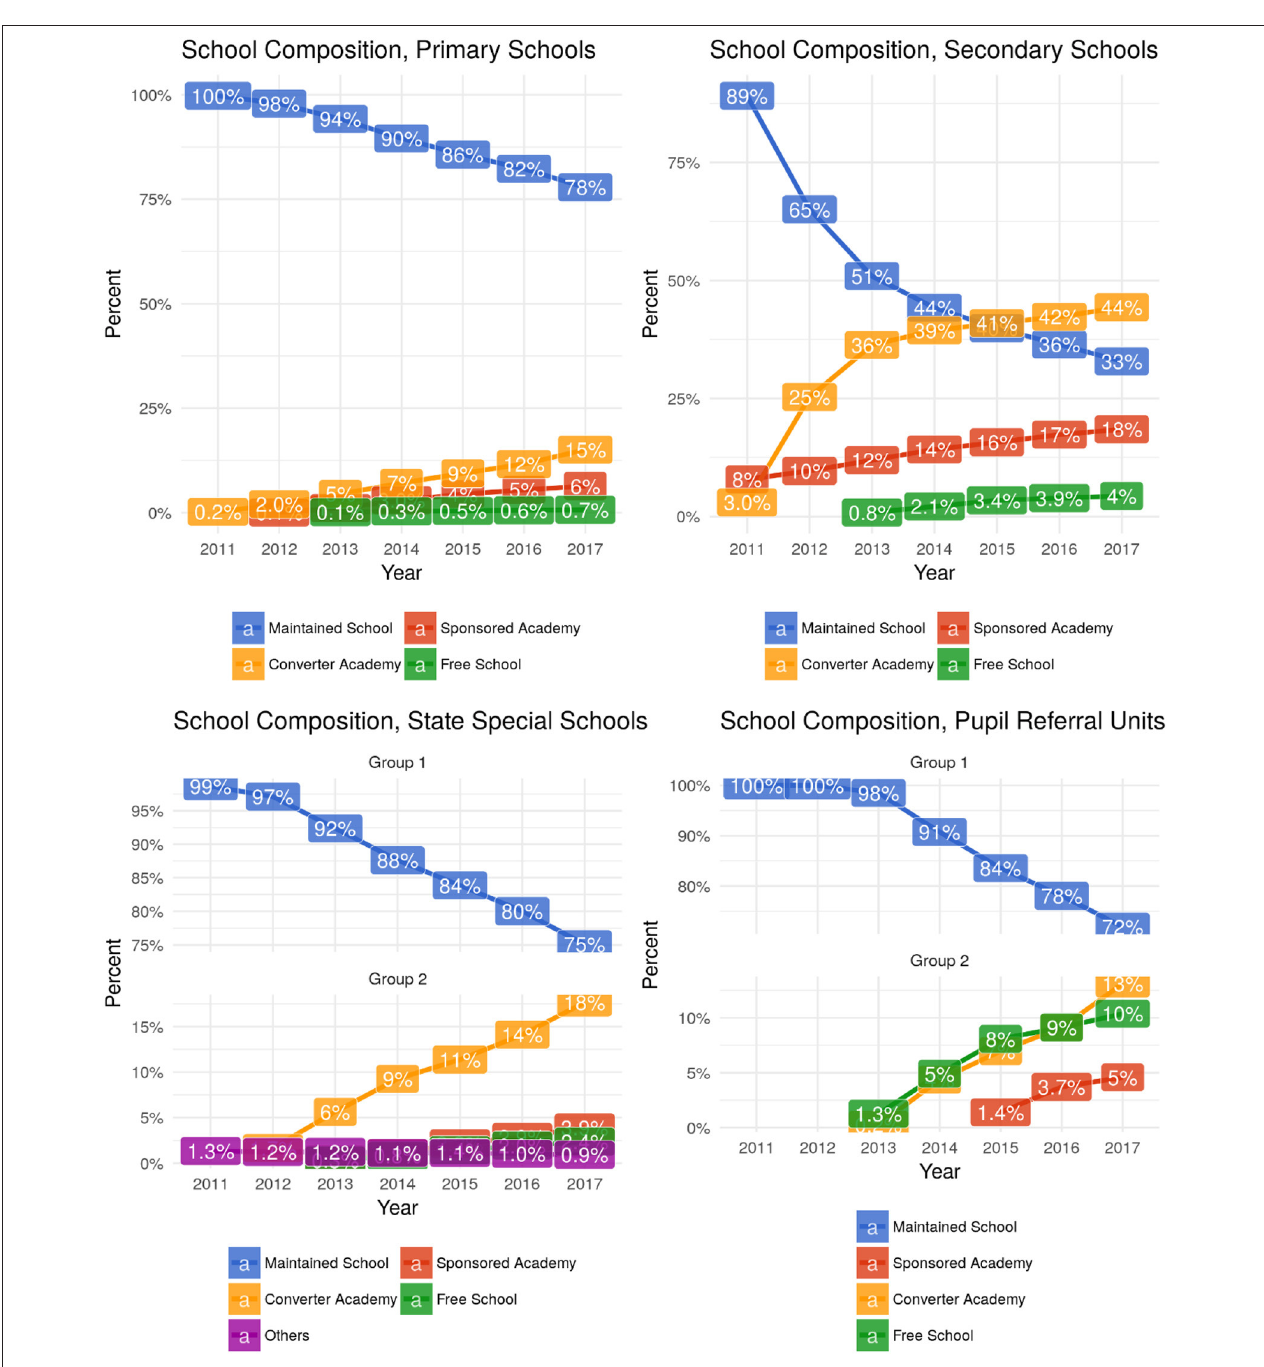
FIGURE 1 | Distributions of schools in England by types and sector, 2011–2017.